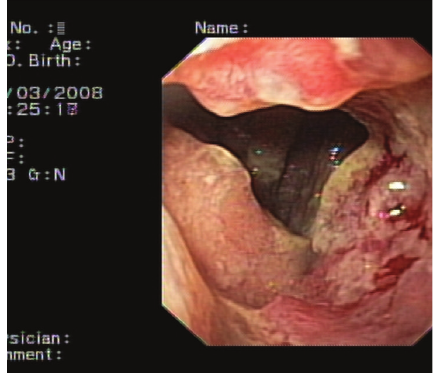
Figure 3: Endoscopy showed circumferential tumor at the ileocae- cal junction.